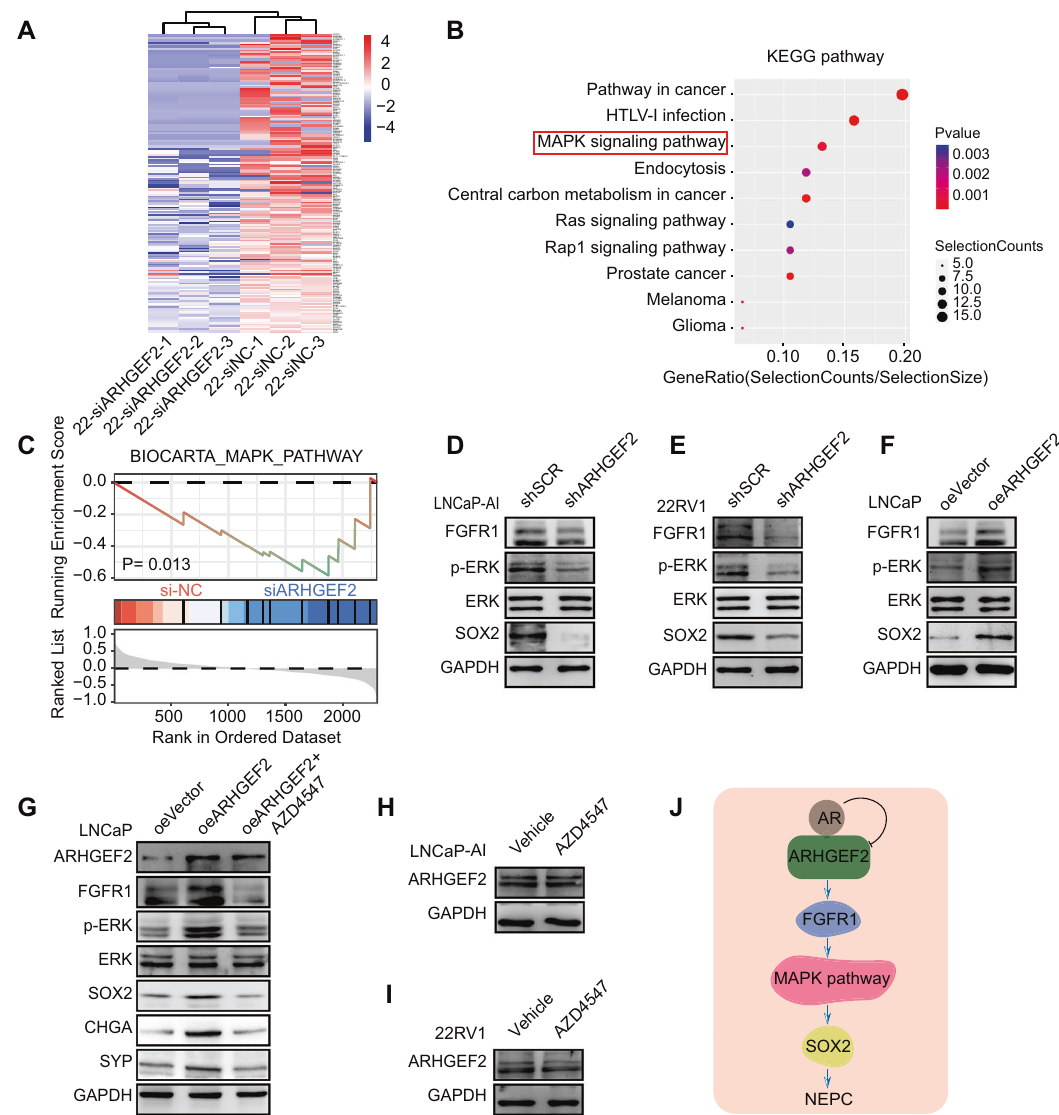
Fig. 5 ARHGEF2 regulate SOX2 via FGFR1/MAPK pathway in PCa. A Heatmap showing genes up-regulated (red) or down-regulated (blue) in 22RV1 ARHGEF2 downregulated cells obtained by RNA-seq analysis. B , C KEGG pathway enrichment ( B ) and GSEA ( C ) analysis showing the MAPK pathway enriched in the 22RV1-siARHGEF2 group relative to control. D , E Immunoblot analysis for protein levels in SOX2 and FGFR1/ MAPK pathway in ARHGEF2-silenced (shARHGEF2) and control (shSCR) LNCaP-AI (left) and 22RV1 (right) cells. F Immunoblot analysis for protein levels in SOX2 and FGFR1/MAPK pathway in ARHGEF2-overexpressed (oeARHGEF2) and control (oeVector) LNCaP cells. G Immunoblot analysis for protein levels in SOX2 and FGFR1/MAPK pathway using the same cells as F treated with AZD4547. AZD4547, a selective FGFR inhibitor [50]. H , I Immunoblot analysis for protein levels in ARHGEF2 using the LNCaP-AI and 22RV1 cells treated with Vehicle and AZD4547. J Illustration showing AR-repressed ARHGEF2 regulate SOX2 via FGFR1/MAPK pathway in prostate cancer. AR, androgen receptor; ARHGEF2, Rho guanine nucleotide exchange factor 2; FGFR1, fi broblast growth factor receptor 1; SOX2 SRY-Box transcription factor 2; NE